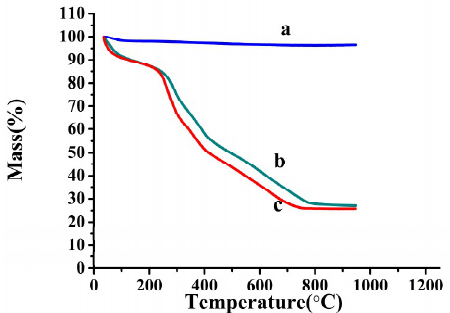
Figure 3. Thermogravimetric profile of: ( a ) Fe 3 O 4 @SiO 2 ; ( b ) Fe 3 O 4 @CTS/SiO 2 composite; and ( c ) Fe 3 O 4 @CTS/SiO 2 -C 12 composite.